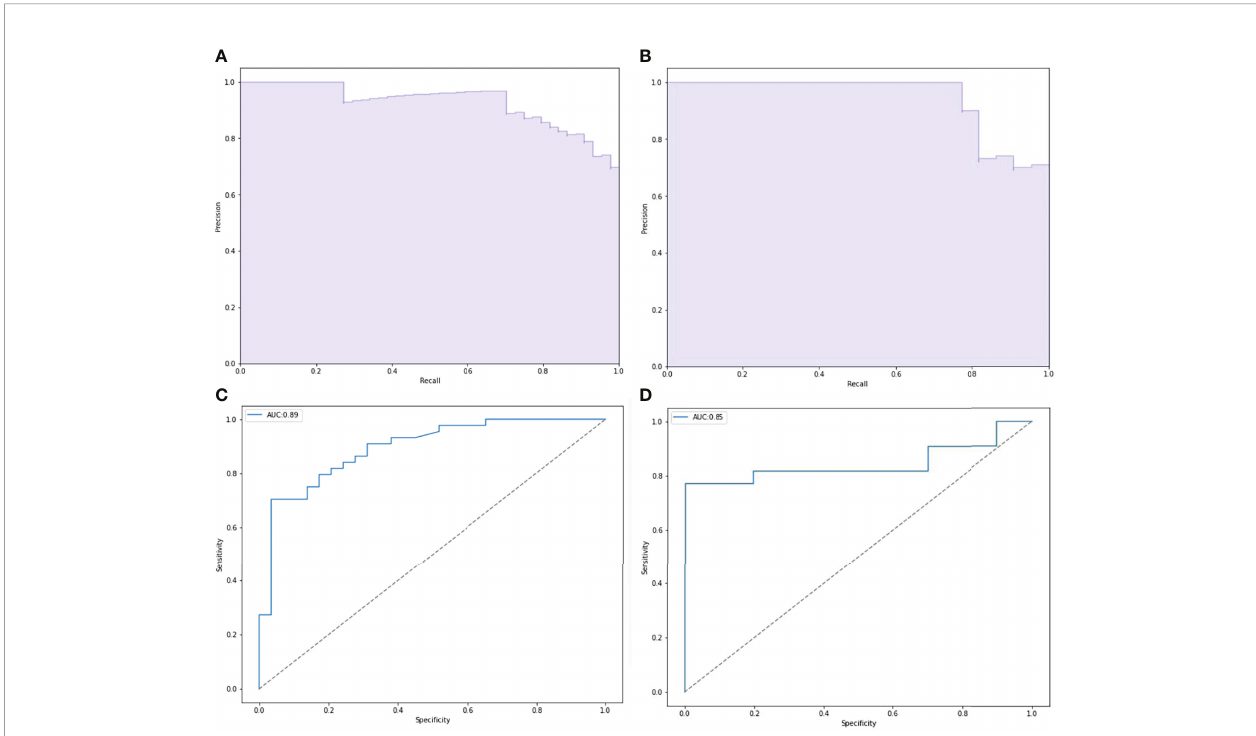
FIGURE 5 | Performance of NF2 status predictive models based on SVM. (A, C) Receiver operating characteristic (ROC) curve and precision-recall (P-R) curve of SVM predictive model in training group. (B, D) ROC curve and P-R curve of SVM predictive model in validation